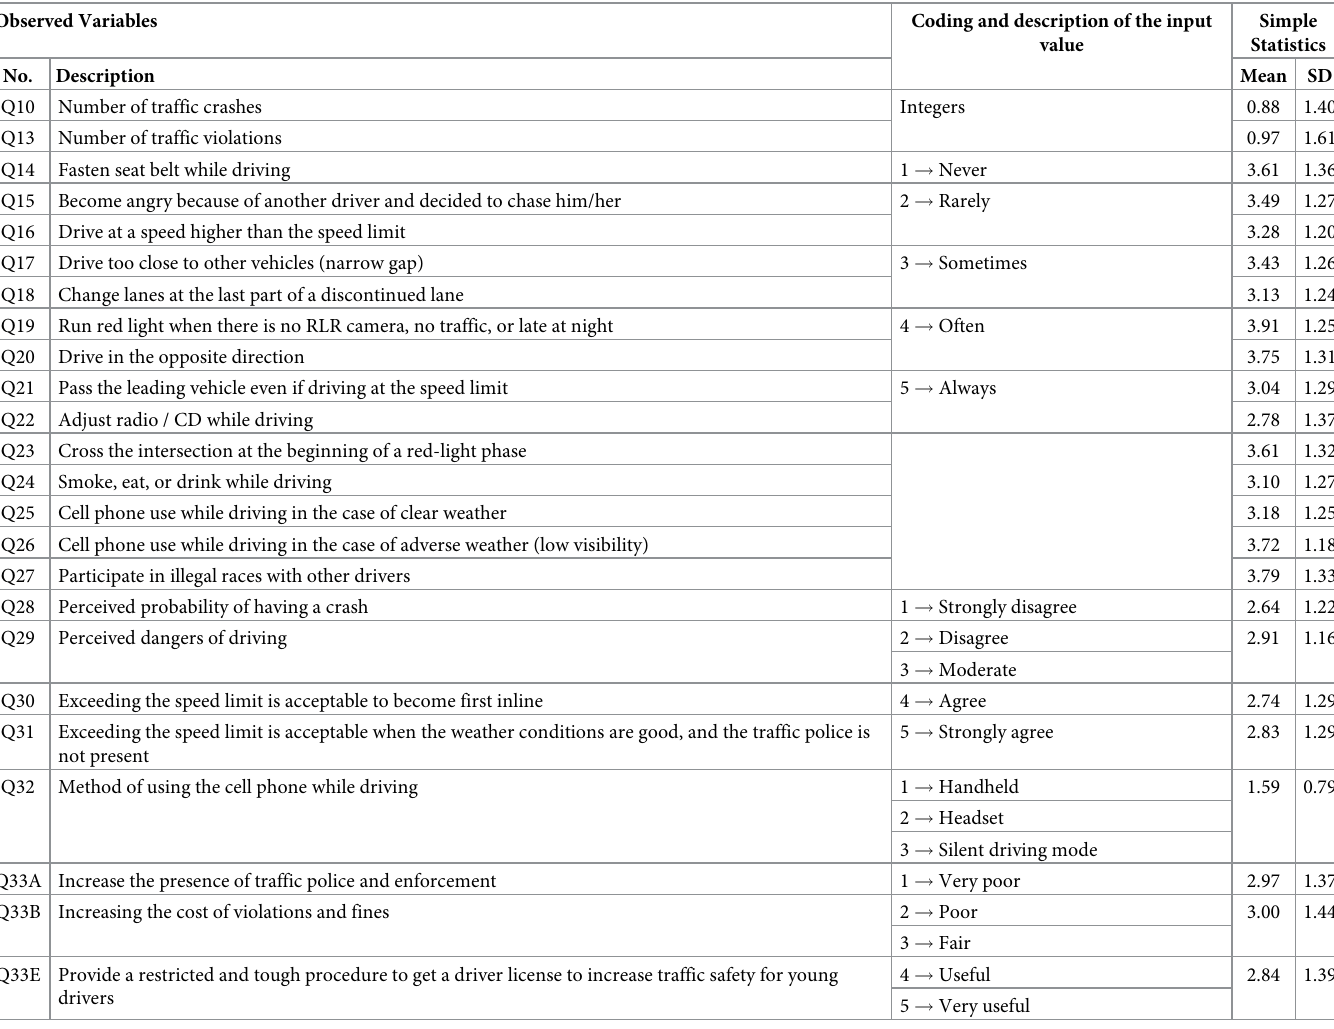
Table 3. Description, codes, and simple statistics for the variables used in the EFA